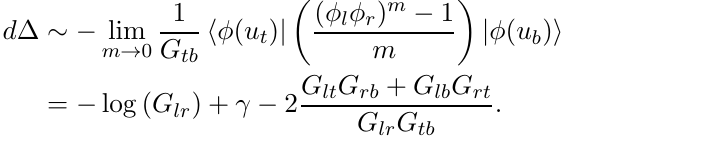
Figure 12 . We consider the diagrams contributing to the correlator In green is the desired contribution which mimics the action of the charges in (cid:12)gure 5(a). The \bad" diagrams (displayed in black) are morally similar to the ones in (cid:12)gure